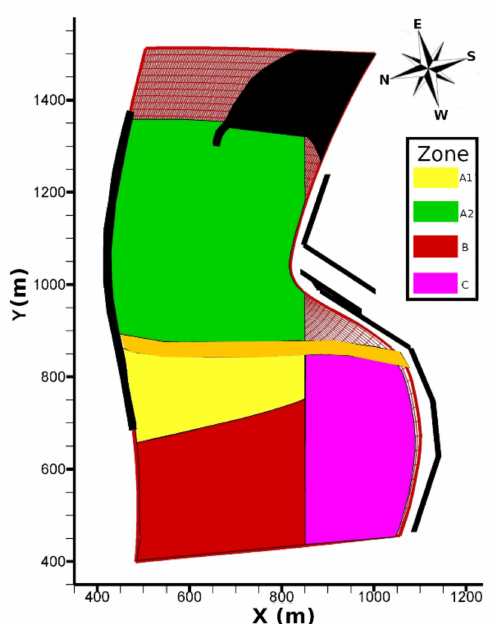
Figure 15. Zones partition for the evaluation of the volume of sedimented materials. Configuration